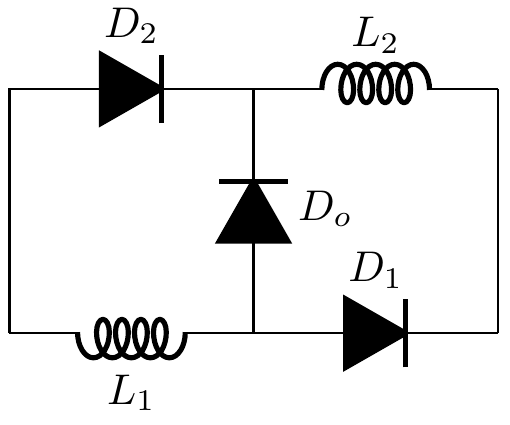
Figure 14. Basic Switched Inductor (SL)